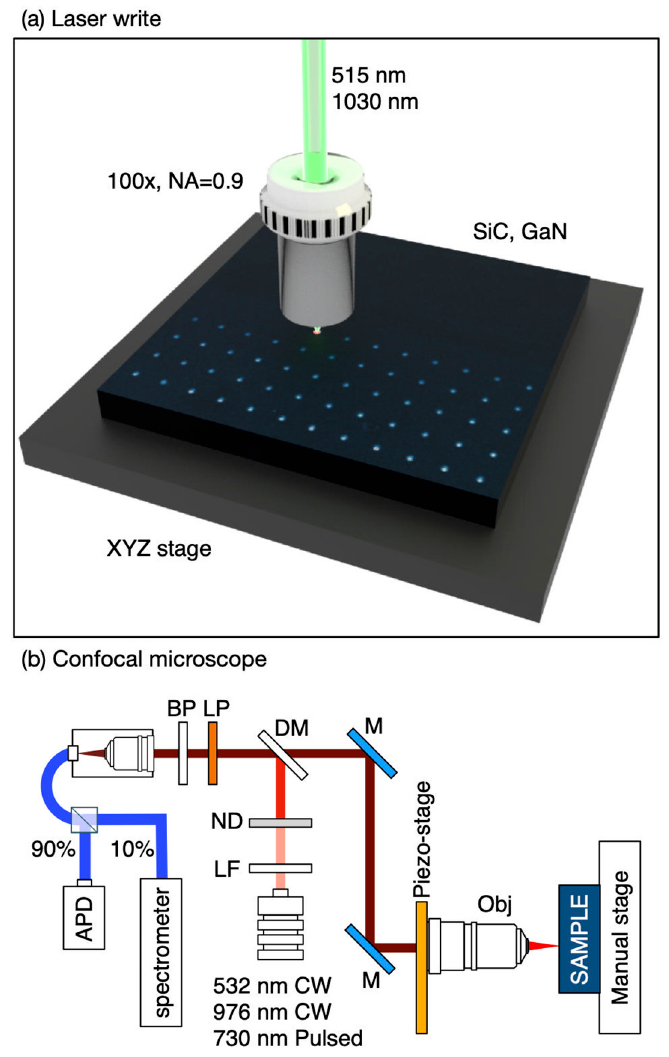
Figure 1. ( a ) Conceptual drawing of the laser writing system for color center creation. ( b ) Schematic diagram of the confocal fluorescence microscope.